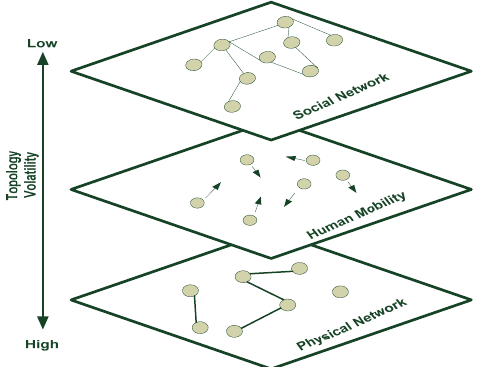
Figure 1. A mobile social network’s structural topology. On the top layer, the social network drives human to move, and this human mobility creates opportunistic contacts in the physical network.